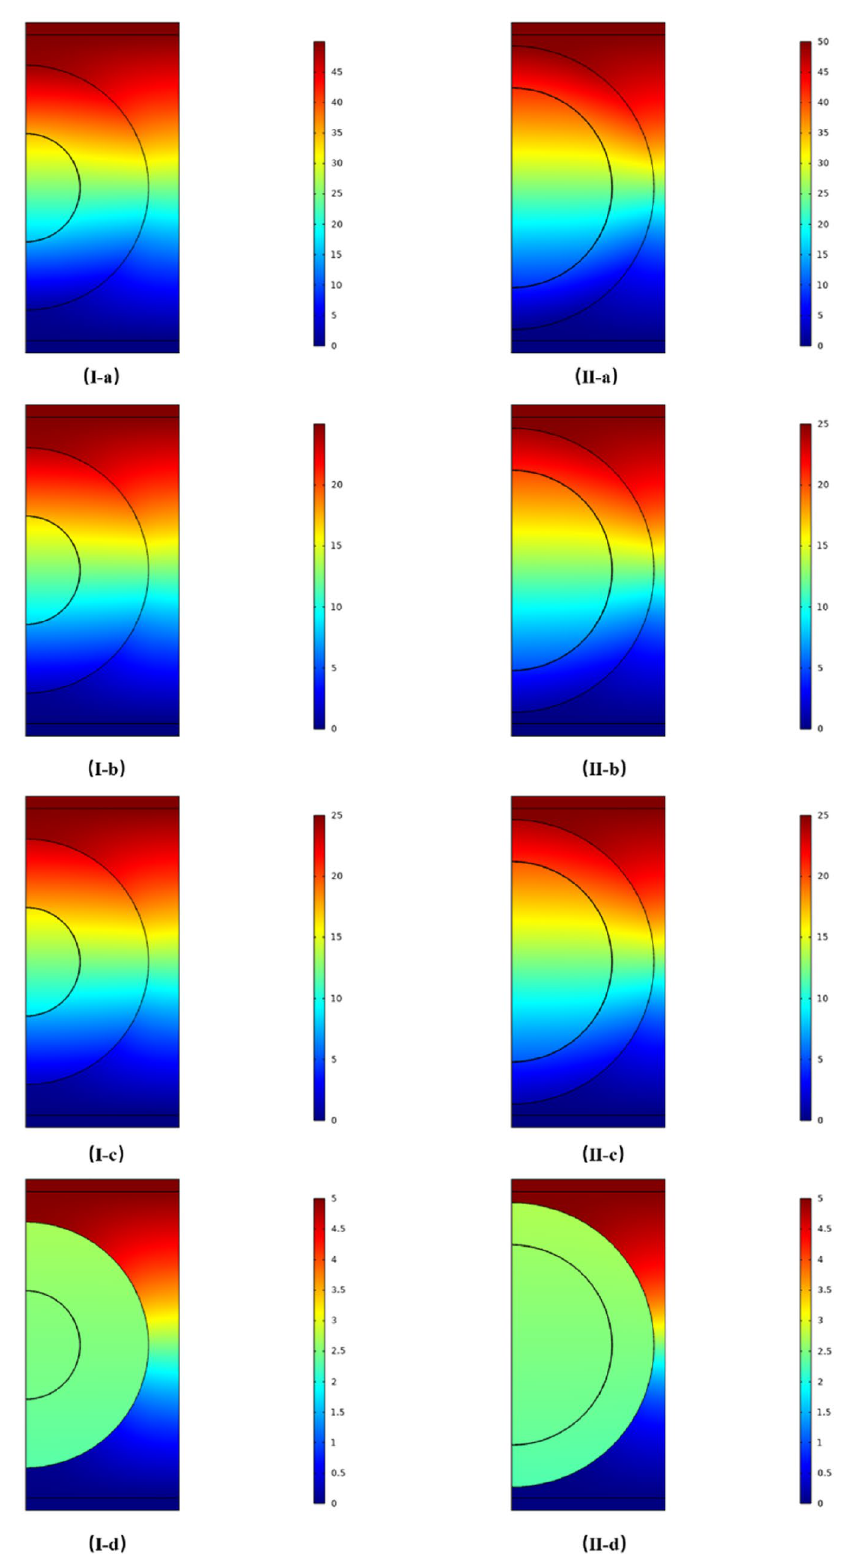
Figure 3. The potentials on the middle cross section of the normal ( I-a , b , c , d ) and cancerous ( II-a , b , c , d ) cell models with different time width pulses; ( I , II-a ): pulse width is 30 ns, voltage is 50 V, and time is 15 ns; ( I , II-b ): pulse width is 300 ns , voltage is 25 V, and time is 150 ns; ( I , II-c ): pulse width is 500 ns, voltage is 25 V, and time is 250 ns; ( I , II-d ): pulse width is 100 μs, voltage is 5 V, and time is 50